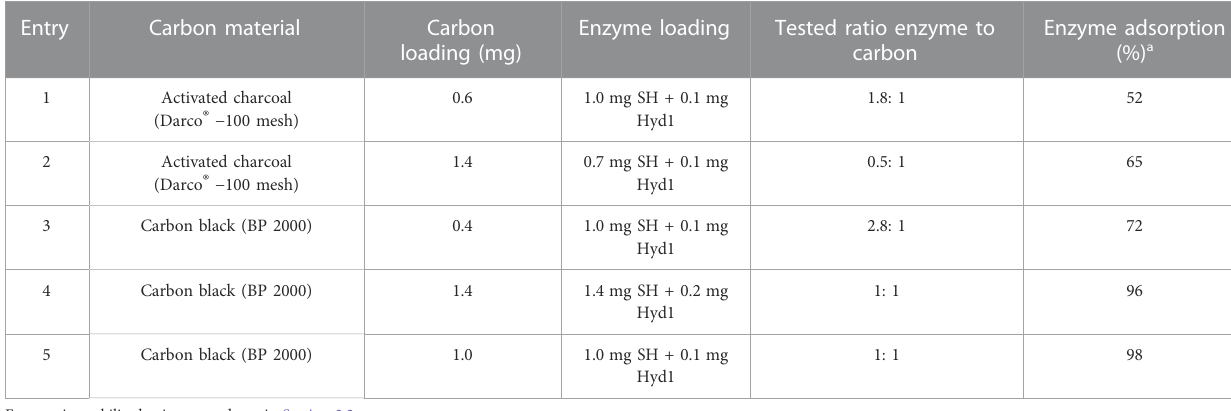
TABLE 1 Extent of enzyme immobilisation on carbon